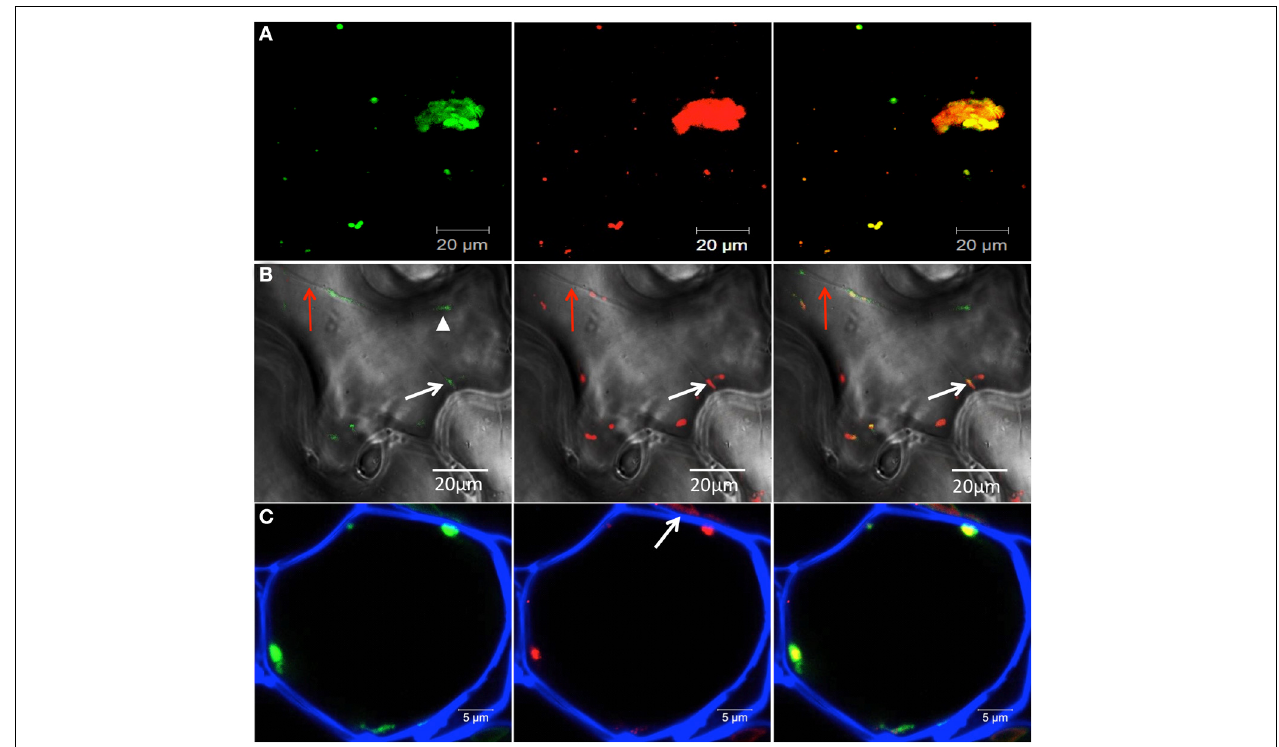
FIGURE 2 | 6K 2 -induced vesicles contain RdRp and viral RNA. (A,B) Confocal images of leaf epidermal cells of N. benthamiana showing RdRp:GFP (left panel) in TuMV-infected cells producing 6K 2 :mCherry-tagged vesicles (middle panel) and merged data (right panel). Images shown in (A) are three-dimensional projections of > 30 1- µ m-thick slices that overlap by 0.5 µ m. Images shown in (B) are single optical images with bright-field illumination. Red arrow indicates a transvacuolar strand, white arrow shows a 6K 2 -induced